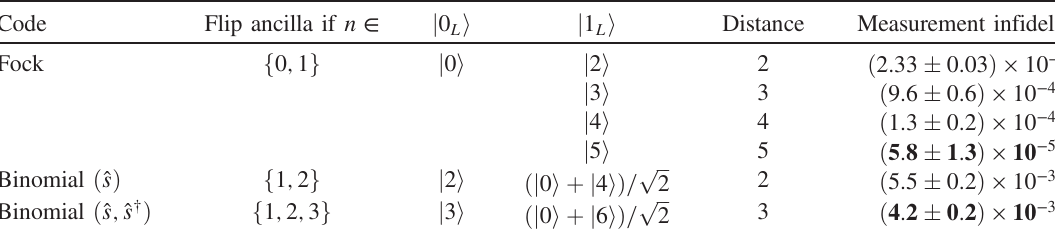
TABLE I. List of codes, mapping operations, and results. Here, we list the bosonic codes studied, along with their logical Z codewords, the distance between codewords with respect to the lowering operator a , and the subset of photon numbers for which the ancilla is excited. Experimental measurement infidelities are listed according to the logical encoding and quoted for the number N of measurements which minimizes each. The best value for each class of code is highlighted in